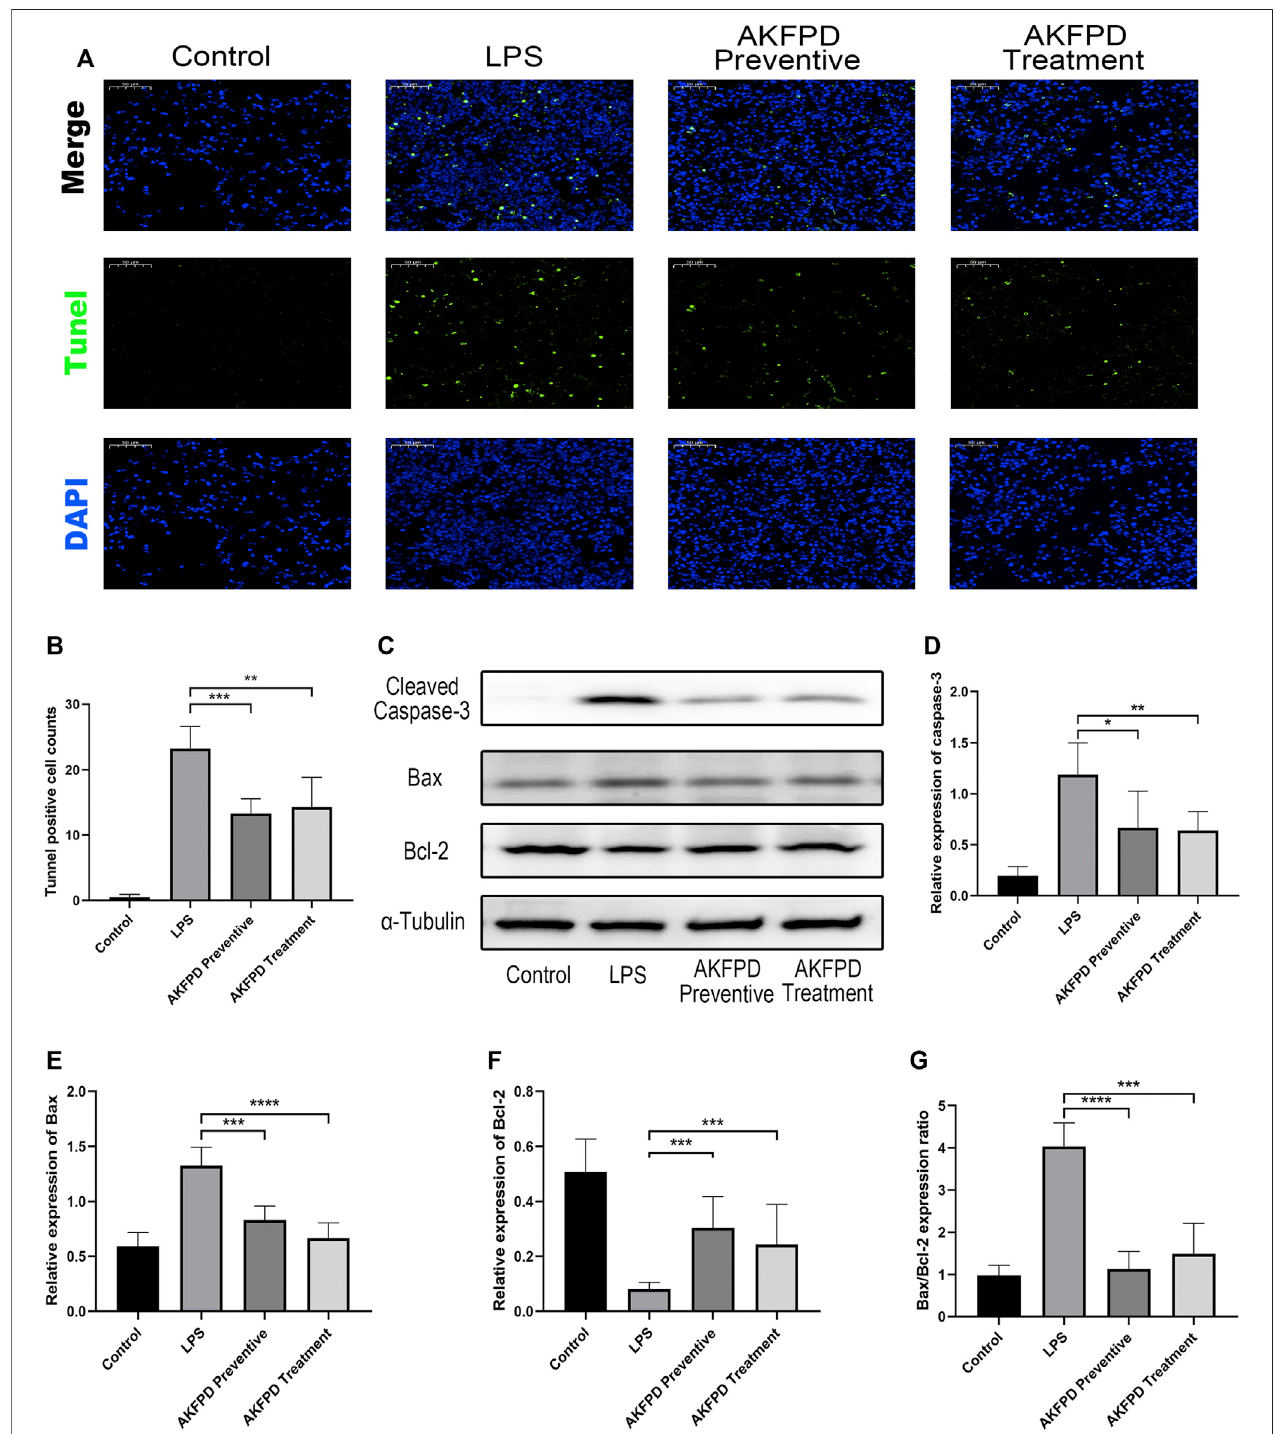
FIGURE 3 | Fluorofenidone decreased the pulmonary in fl ammation in the LPS-induced mouse model. (A,B) Representative images of TUNEL staining of lung tissuesand positivecellcount analysisofdifferentgroups. GreenrepresentsTUNELpositivecells, and bluerepresentsthenucleus. Scale bar (cid:1) 50 μ m. (C) Western blot and analysis of cleaved caspase-3, Bax, and Bcl-2 in the lung tissue. (D – G) Quanti fi cation of cleaved caspase-3, Bax, Bcl-2, and the ratio of Bax to Bcl-2 in the lung tissue. Data were represented as mean ± SD. n (cid:1) 6 per group. * p < 0.05, ** p < 0.01, *** p < 0.005, and **** p < 0.001 vs. the LPS group.